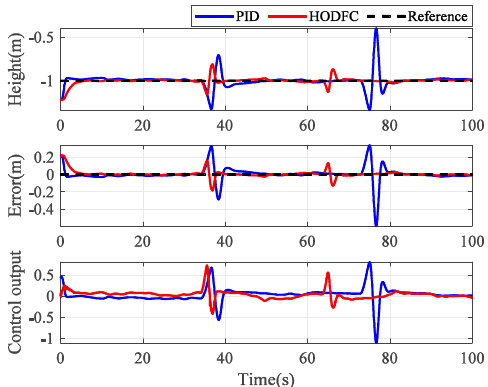
Figure 16. Experimental results of height with human interference.